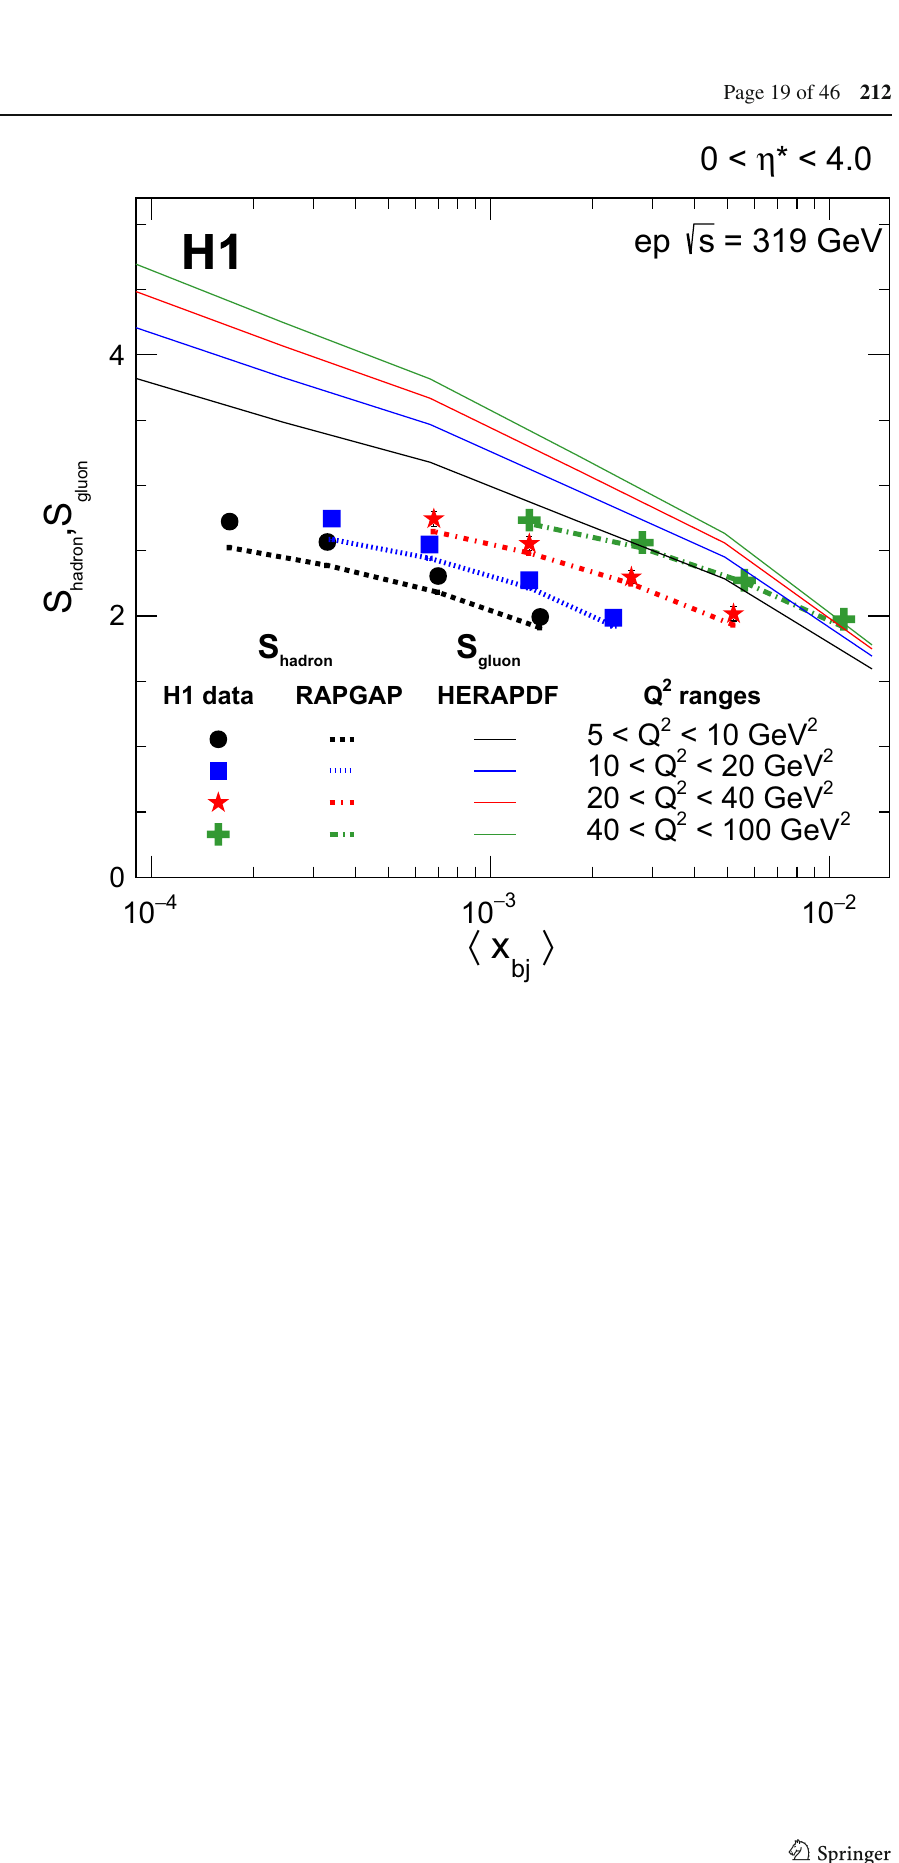
Fig. 12 Hadron entropy S hadron derived from multiplicity distributions as a function of (cid:8) x (cid:9) measured in different Q 2 bj ranges, measured in √ s = 319GeV ep collisions. Here, a restriction to the current hemisphere 0 < η ∗ < 4 is applied. Further phase space restrictions are given in Table 1. Predictions for S hadron from the RAPGAP model and for the entanglement entropy S gluon based on an entanglement model are shown by the dashed lines and solid lines, respectively. For each Q 2 range, the value of the lower boundary is used for predicting S gluon . The total uncertainty on the data is represented by the error bars